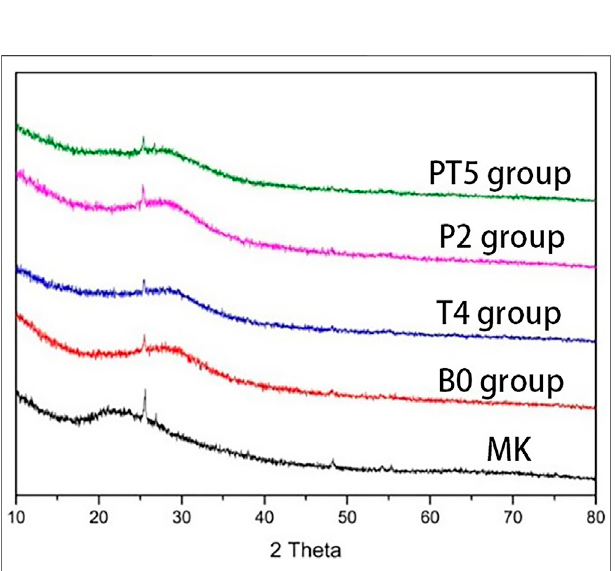
FIGURE 7 | 28-day IR spectrum of PVA fi bre and CNT-strengthened